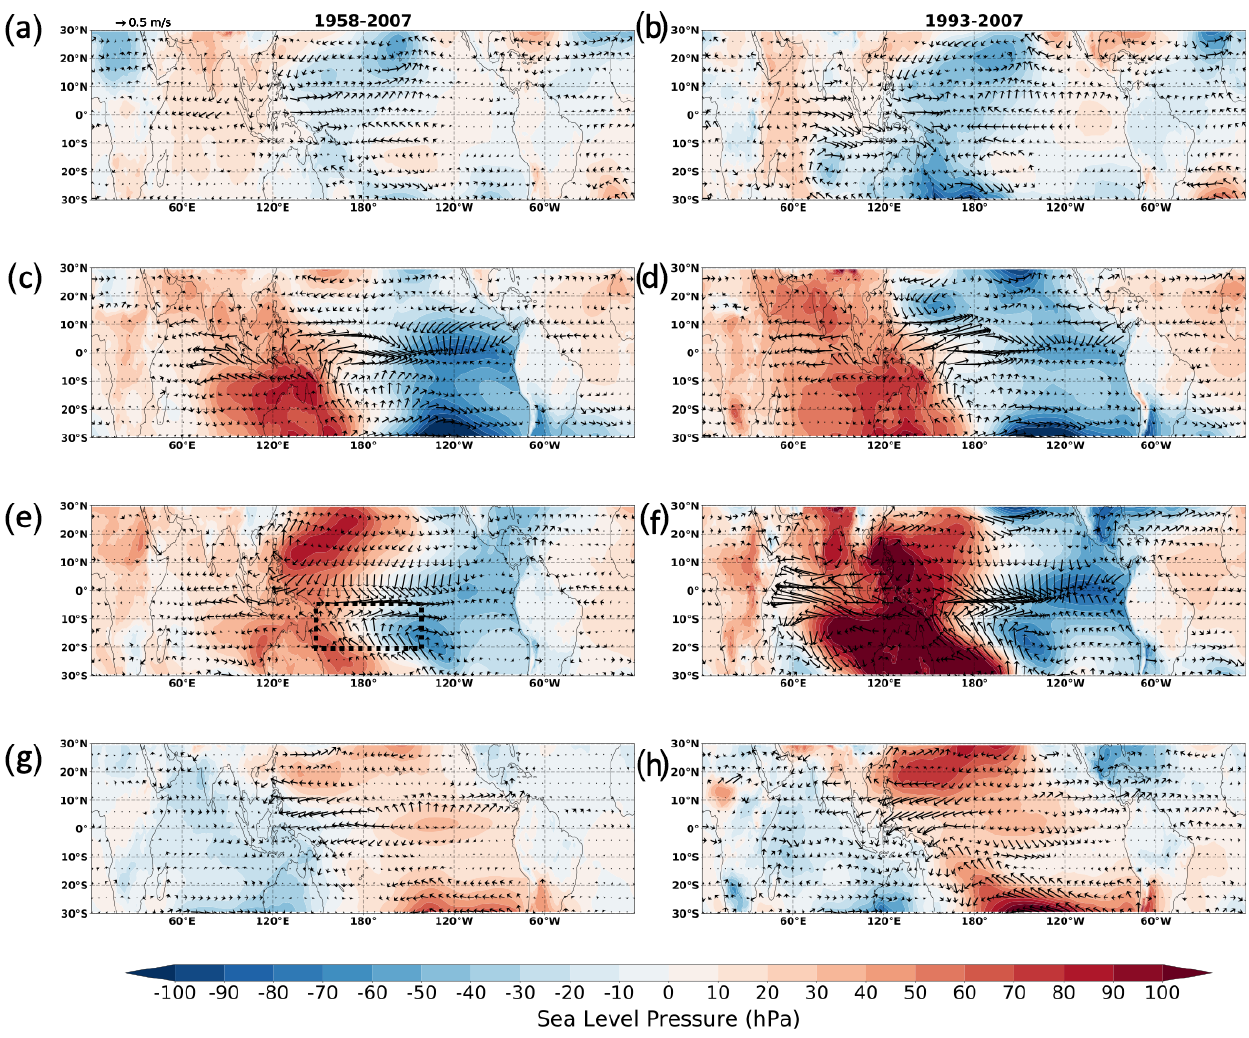
Figure 26. The sea level pressure (shading) and surface wind (vector) from JRA55-do forcing in four different stages (top to bottom), defined in Fig. 24, during the El Niño composite determined over (a, c, e, g) 1958–2007 and (b, d, f, h) 1993–2007. The dashed black box shows the region of asymmetric sea level change in the southwestern tropical Pacific at stage